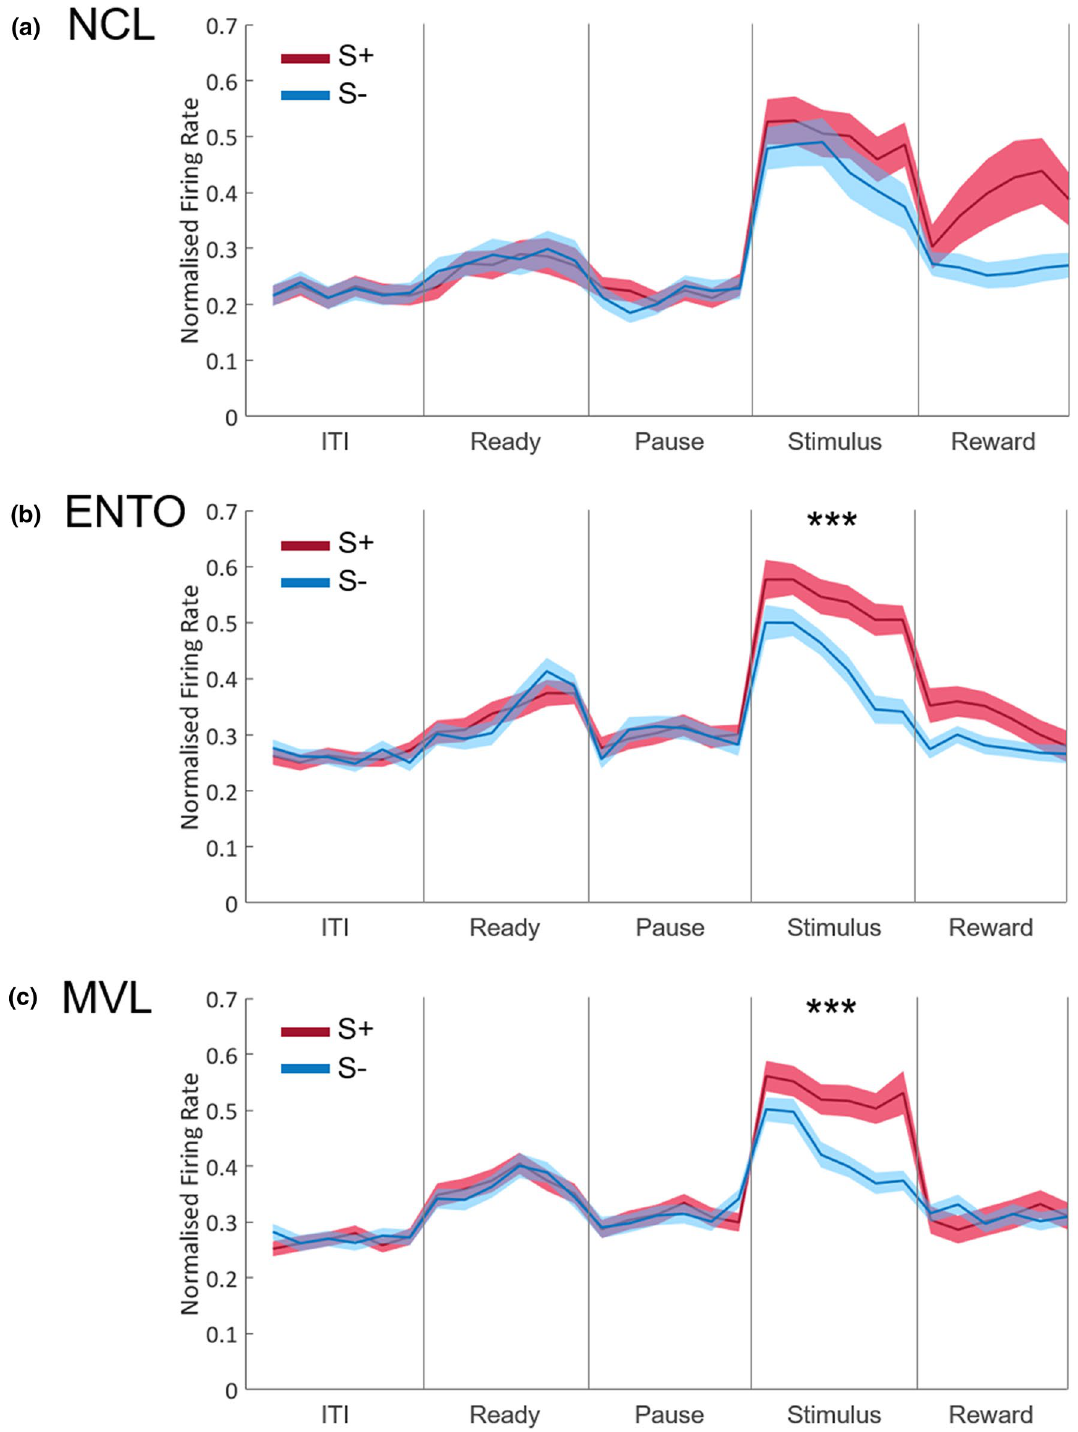
Figure 4. Overall population profiles. The overall population profiles for ( a ) NCL, ( b ) ENTO, and ( c ) MVL. Neuronal data was normalised against the maximum firing rate during the ITI, and bin width is 50 ms. Vertical lines separate the different periods of the task. Shaded bands represent ±1 SEM. ITI, intertrial interval. * p < .02; ** p < .01; *** p <